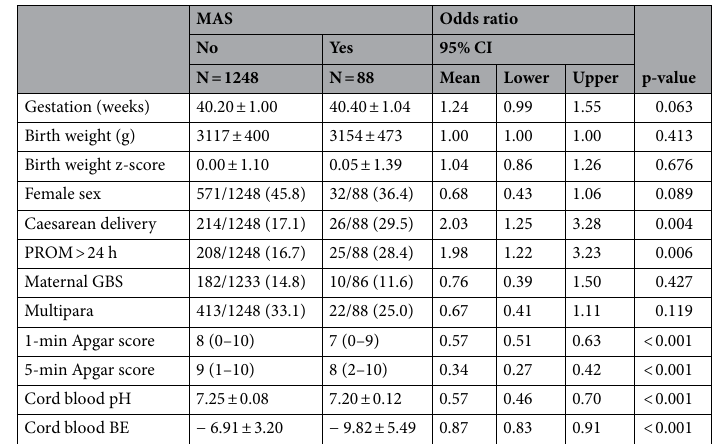
Table 1. Association of the development of meconium aspiration syndrome and clinical variables among neonates with meconium-stained amniotic fluid on univariate analysis. Values are presented as mean ± standard deviation, median (quartile ranges) or number (%). Cord blood pH was calculated as per 0.10 pH change. CI confidence interval, PROM premature rupture of the membrane, GBS Group B streptococcus, BE base